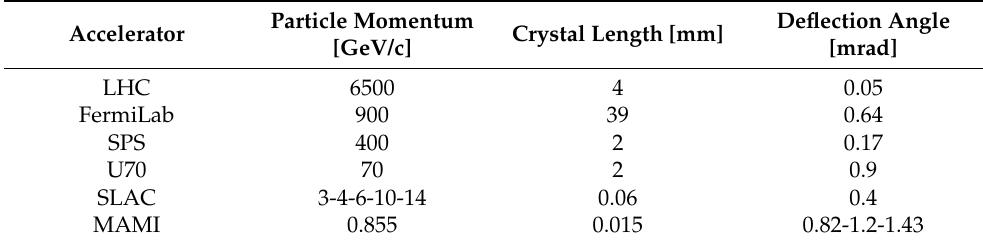
Figure 7. Surface processing on wafer surface, interferometric measures of wafer surfacer before ( a ) and after ( b ) MRF. Thanks to MRF high planarity can be achieved. Table 3. Example of crystal parameters in past